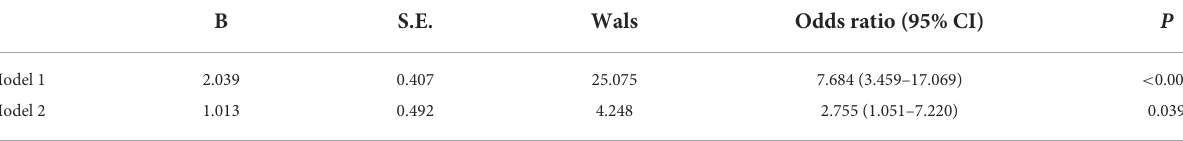
TABLE 5 Relation of serum annexin A7 levels to 90-day poor outcome using multivariate